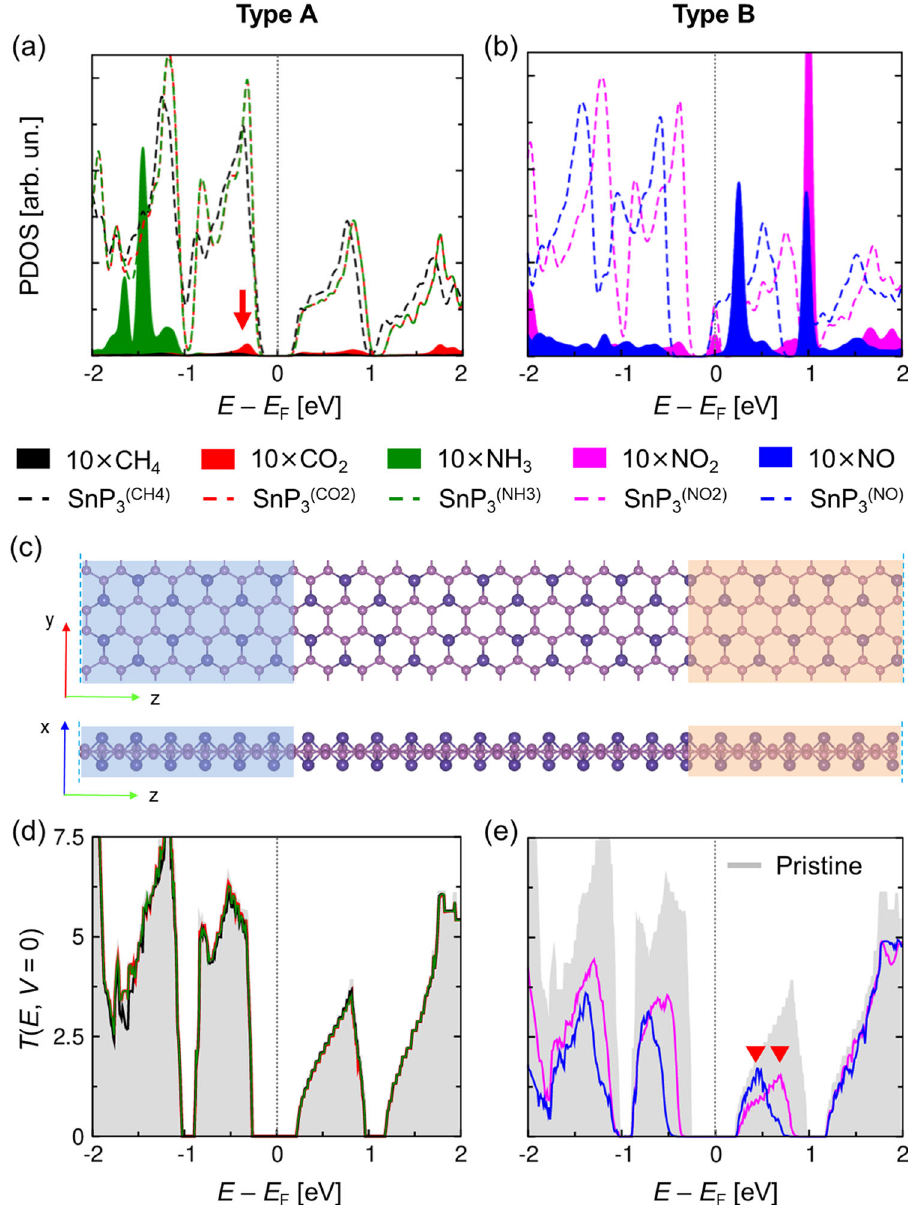
Fig. 3 Electronic structure and transport properties of 111-junction in the presence of gas molecules. PDOS of 1L SnP 3 with adsorbed gas molecules of a type A and b type B. Black, red, green, blue, and magenta colours indicate CH 4 , CO 2 , NH 3 , NO, and NO 2 , respectively. PDOS for each molecule are marked with colour- fi lled peaks and were scaled up ten times for visibility. Dashed lines represent the PDOS of the SnP 3 substrate for each adsorption model, as indicated by SnP 3(molecule) in the legend. Note that the states of CH 4 lie outside the energy range plotted here. The red downwards arrow indicates the electronic state of CO 2 near E F . c Top view (top) and side view (bottom) of the device (111-junction) used to calculate the transmission. Blue and orange shaded regions indicate the left and right leads, respectively. Transmission functions for 111-junction with each adsorbed gas molecule with d type A and e type B molecules, indicated by solid lines with the colour corresponding to those used in PDOS. The T ( E , V = 0) of the pristine 111-junction is marked in grey. Note that this model is designed to observe the effect of molecular adsorption on electron transport, so that the dimension of this model is different from what is used in Fig. 1g (Supplementary Fig. 1) with which we compare pristine 111-, 222-, and 333-junctions without molecular adsorption. Furthermore, the model is designed to be also comparable to 3L SnP 3 (metal) — 1L SnP 3 (semiconductor) — 3L SnP 3 (metal) junction which we will denote as 313-junction in the later part of this paper. In order to accommodate molecules in the scattering region and avoid the possible effects of edge states comes from the 1L-3L SnP 3 interfaces, the scattering region in this model is longer by almost two times than what is used in Fig. 1g (Supplementary Fig. 1). The red downward triangles indicate the fi rst transmission peaks above E F of the 111-junction with NO and NO 2 adsorptions. Note that the slight difference between this T ( E , V = 0) of pristine 111-junction and Fig. 1g comes from above-mentioned difference in the dimension of atomistic